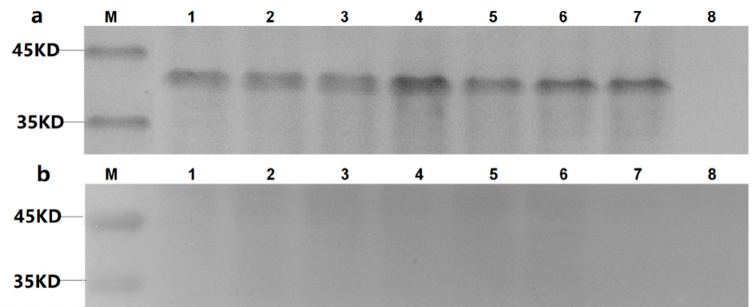
Figure 2. Detection of the recombinant protein expression in Sf9 cells by western blotting assay: ( a ) the Sf9 cells transfected by different recombinant bacmids were detected by western blot with anti-His mAb as the primary antibody; ( b ) the Sf9 cells transfected by different recombinant bacmids were detected by western blot with mAb 4E6 as the primary antibody. Lanes 1–6 represent for cells respectively infected by b1VP0, b1VP3, b1VP1, b3VP0, b3VP3, b3VP1; lane 7 represents for cells infected by wild baculovirus; lane 8 represents for cells un-infected.